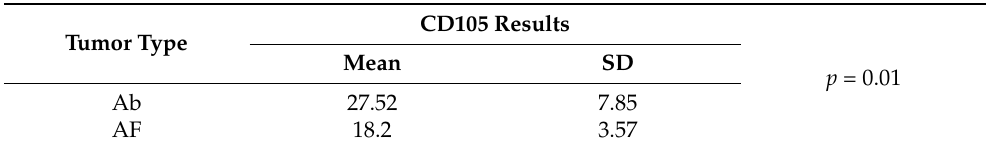
Table 2. Comparison between CD105 protein expression results in ameloblastoma versus ameloblas- tic